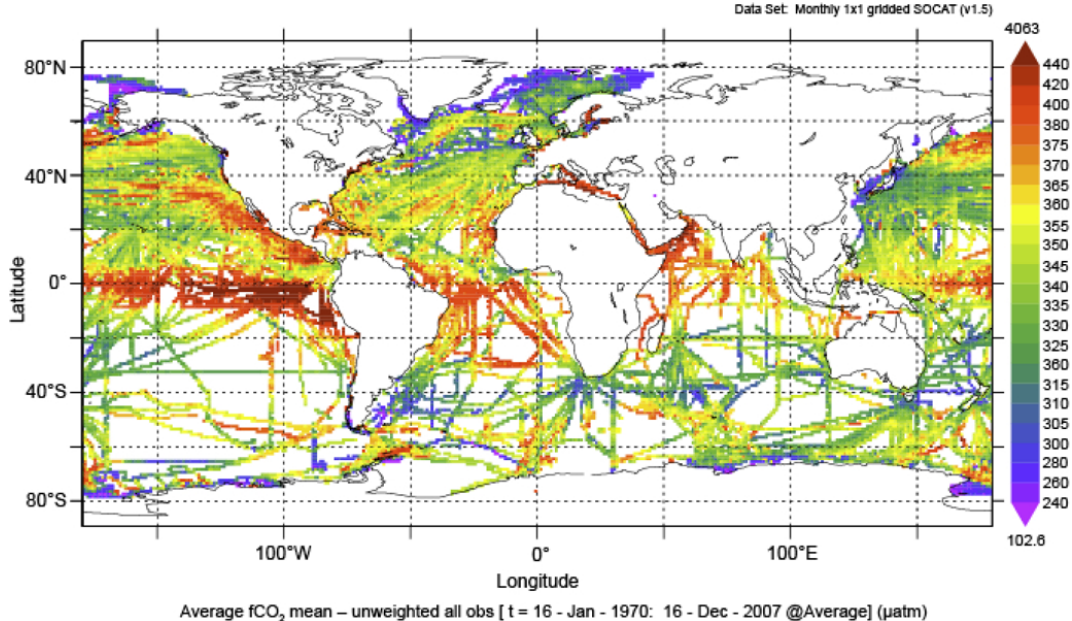
Figure 1. Map of the mean unweighted surface water f CO 2 ( µ atm) based on data in SOCAT database (1970–2007) as generated by the online Live Access